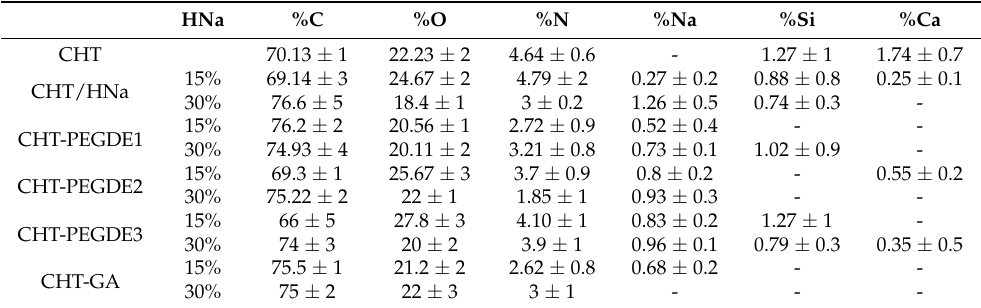
Table 4. XPS elemental composition of chitosan/HNa films crosslinked with GA and PEGDE.